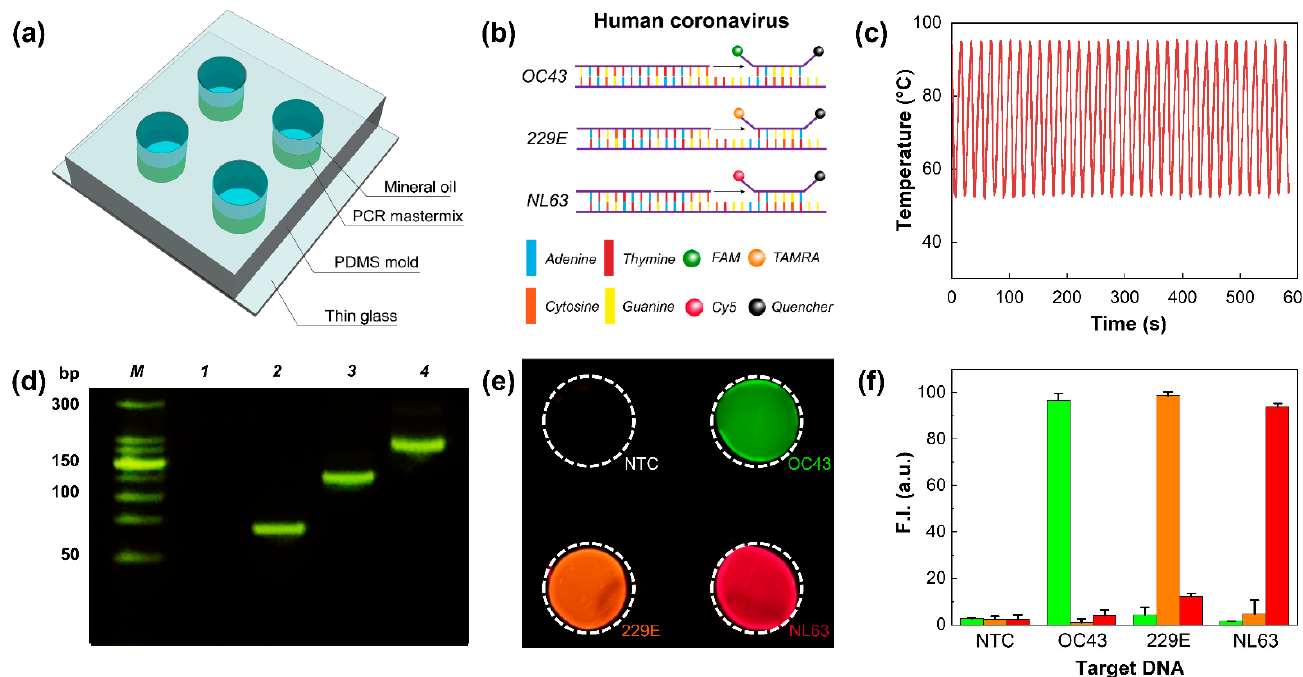
Figure 6. PCR applications of the Ag/CF film-based thermal cycler: ( a ) schematic drawing of multiplexed PCR assay; ( b ) hydrolysis of different TaqMan probes generating distinct fluorescence signals; ( c ) temperature profile of 35 cycles of PCR; ( d ) gel electrophoresis image representing the amplicons. Lane M: 1kb DNA ladder, Lane 1: NTC, Lane 2: OC43, Lane 3: 229E, Lane 4: NL63; ( e ) fluorescence image representing multiplexed PCR assay; ( f ) graph representing fluorescence intensities of the fluorescence intensities.